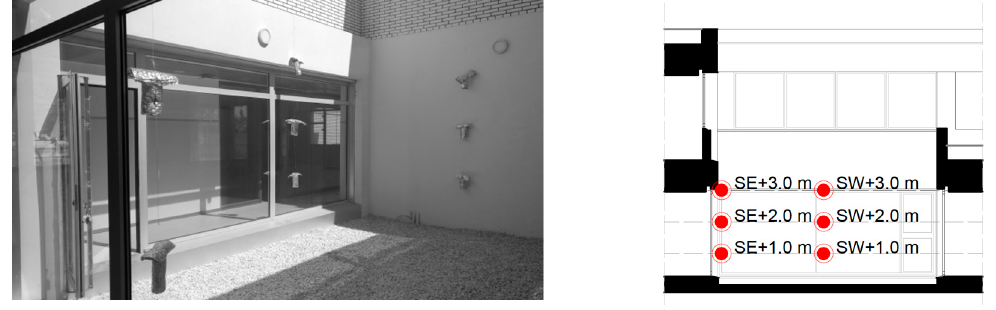
Figure 6. Case study 2: data loggers’ location in the south-east (SE) and south-west (SW) facade.